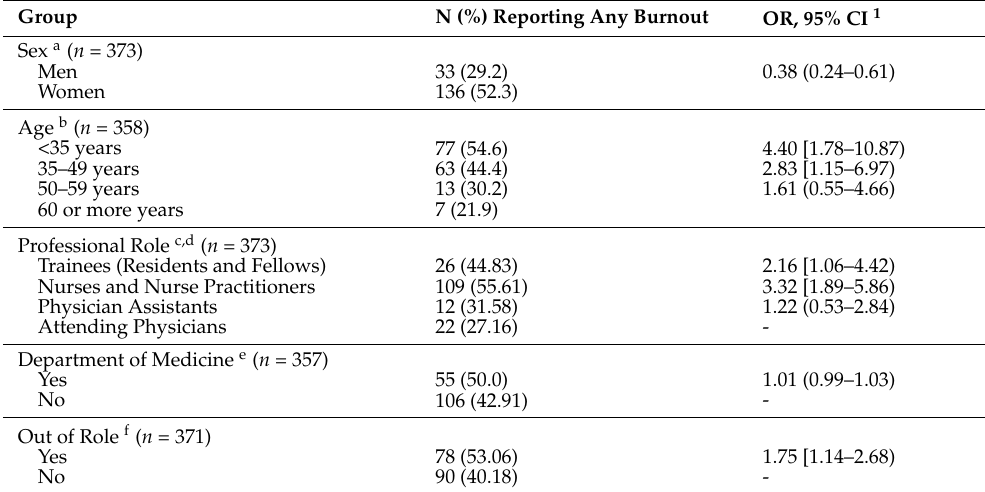
Table 2. Initial Assessment: Odds ratios (OR) and proportions of participants reporting burnout by demographic and professional role